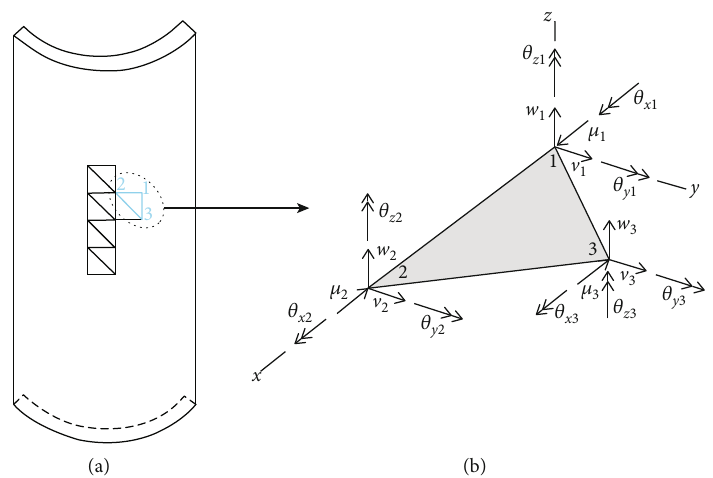
Figure 2: Schematic diagram of the shell element coordinate system: (a) shell elements attached to the surface of the solid zones; (b) local coordinate system de fi nition of a shell